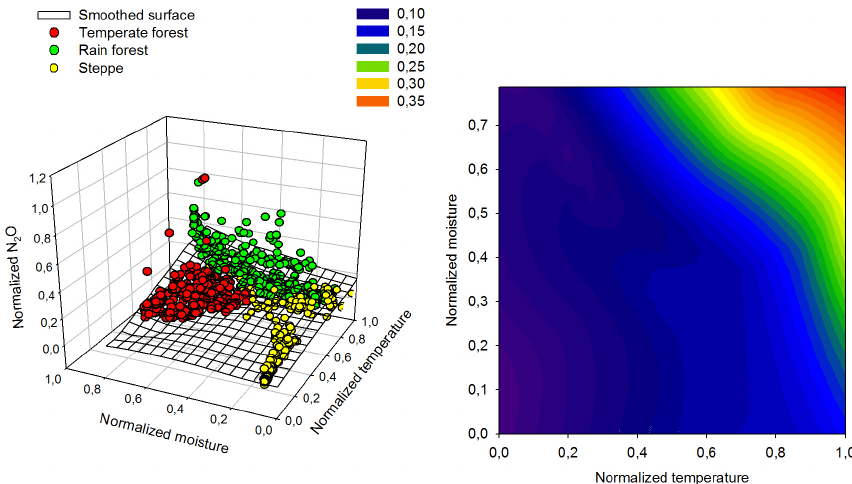
Fig. 10. Temperature and moisture effects on nitrous oxide fluxes (data for freeze–thaw periods at the temperate forest and steppe sites excluded) across all three ecosystems (temperate forest, semi-arid steppe, tropical forest). For this analysis soil moisture and soil temperature as well as nitrous oxide fluxes were normalized across ecosystems (see Fig. 9). Prior to the calculation of contour lines, data were smoothed with the loess algorithm (sampling proportion = 0.5). Data for temperate forest were randomly selected from observations in the years 1995 and